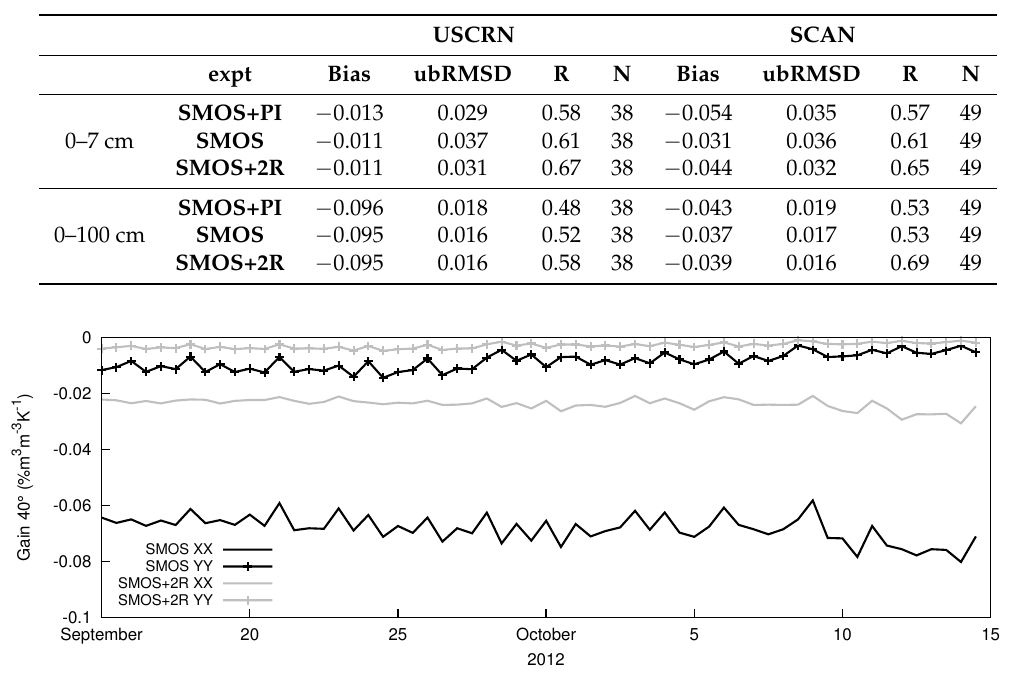
Figure 4. Averaged time series of the 40 ◦ incidence angle gain component for the SMOS and the SMOS+2R